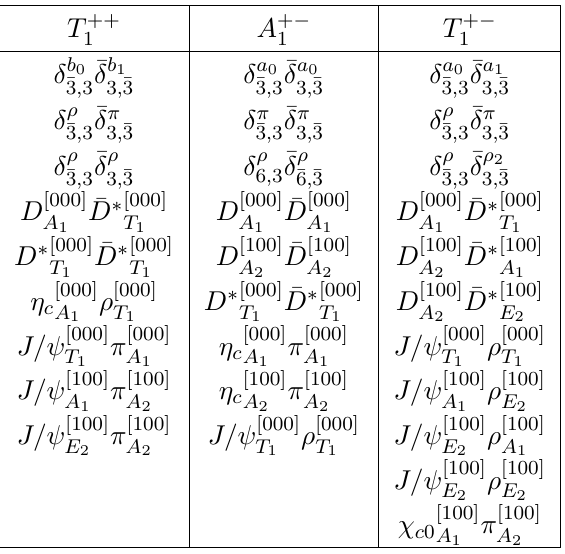
Table 6 . The interpolating operators used to calculate the spectra in the isospin-1 hidden-charm sector. For the tetraquark operators, we use the notation (cid:14) (cid:0) 1 irrep, (cid:0) 1 ((cid:0) 2 ) is the gamma matrix and F 1 ( F 2 ) is the (cid:13)avour irrep of the diquark (anti-diquark) operator. For meson-meson operators, the optimised single-meson operators used are denoted by M [ n 1 n 2 n 3 ] , where M indicates the meson, (cid:3) is the lattice irrep and [ n 1 n 2 n 3 ] is the momentum in (cid:3) units of 2 (cid:25) . Note that all momenta related to [ n 1 n 2 n 3 ] by an allowed lattice rotation are summed L over as shown in equation